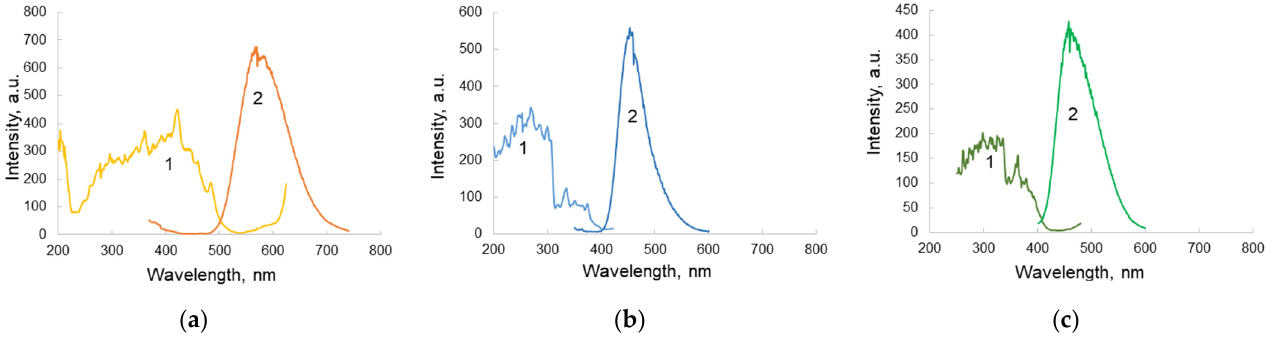
Figure 4. Excitation ( 1 ) and emission ( 2 ) spectra of ZnS:CdS:Cu ( a ); ZnS:Ag ( b ); and ZnS:Cu ( c ).